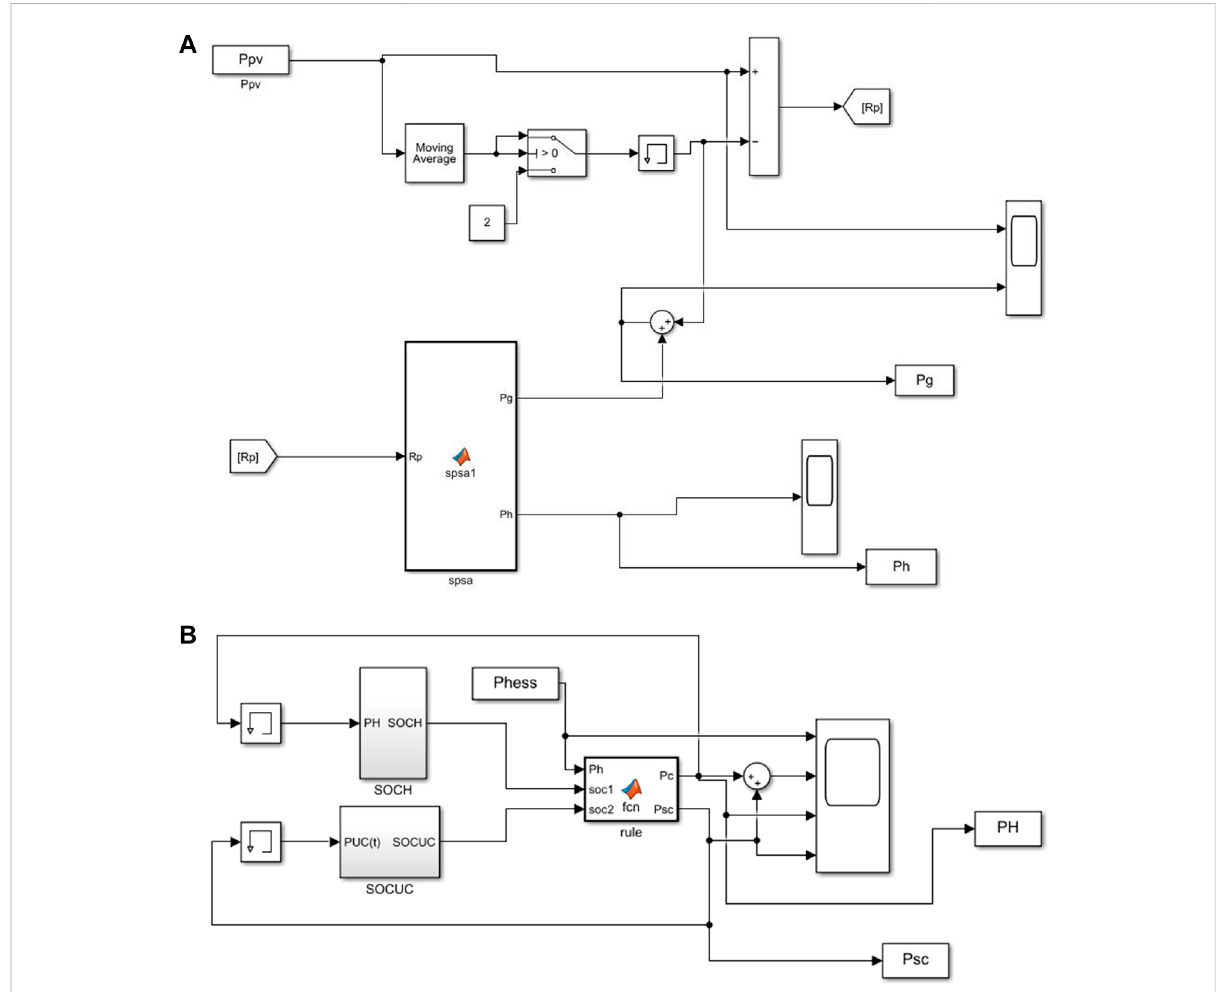
FIGURE 5 Simulation model. (A) Simulation model of the smoothing strategy. (B) Simulation model of the allocation